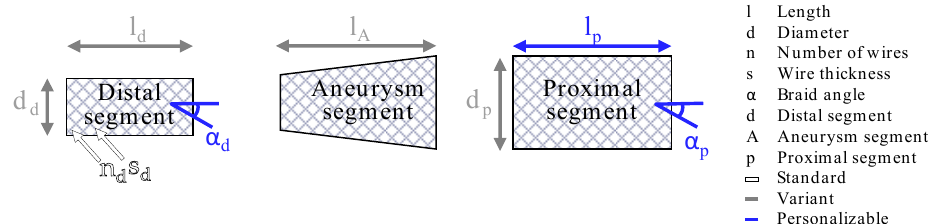
Figure 13. Potential flow diverter concept including three segments with personalizable, variant, and standard product properties.